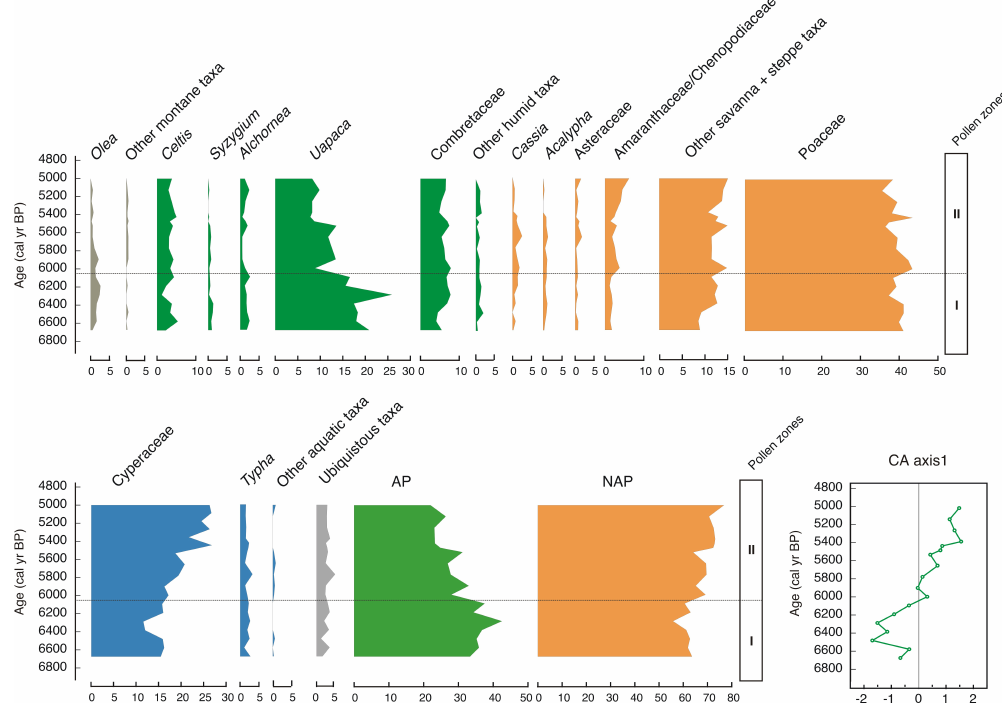
Fig. 4. Synthetic pollen diagram from core LT1, Lake Chad, showing relative percentages of selected taxa (the pollen sum includes all identified pollen and spore taxa, excluding indeterminable grains), and correspondence analysis (CA) performed on the pollen data set.